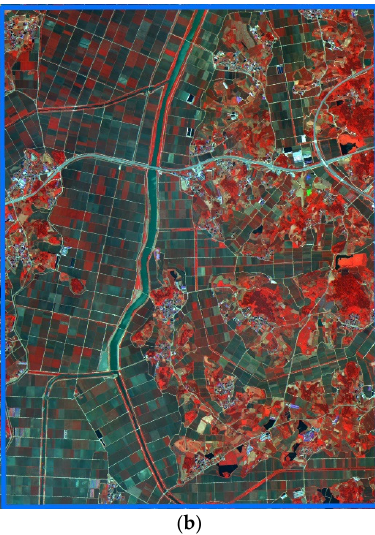
Figure 2. Location of the study area in Korea: ( a ) Full KOMPSAT-3A scene in a natural color composite image taken on 17 June 2016; ( b ) False color composite of study area.